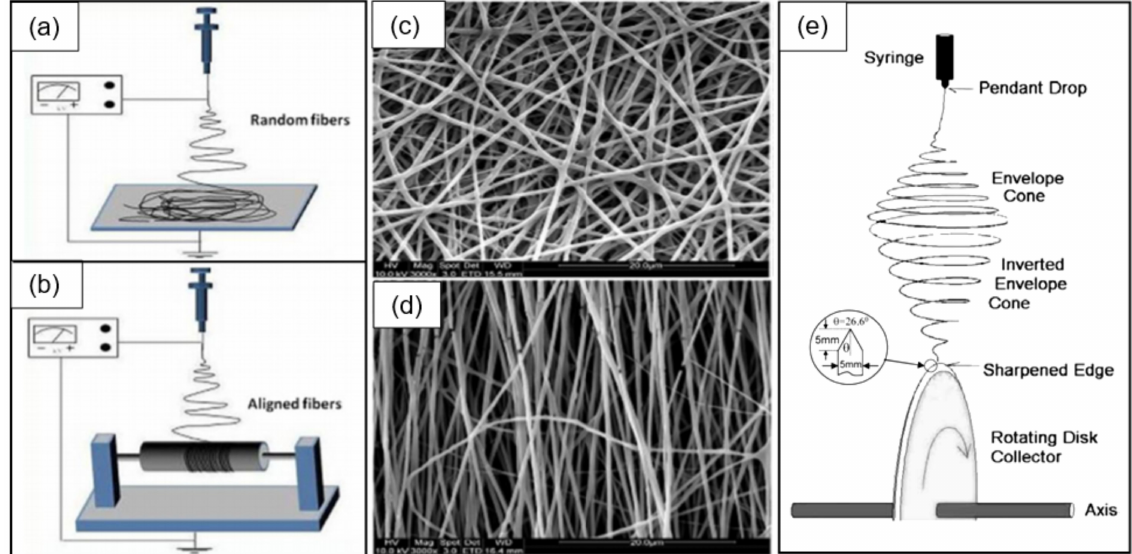
Figure 5. Different approaches to prepare electrospun nanofibers: ( a ) conventional approach, ( b , e ) obtaining aligned electrospun nanofibers ( b ) by a high-speed rotating drum and ( e ) by a sharp-edged rotating disk; ( c , d ) SEM images of ( c ) random and ( d ) aligned nanofibers. ( a-d ) Reprinted with permission from [96]. Copyrights 2013 Wiley; ( e ) Reprinted with permission from [97]. Copyright 2001